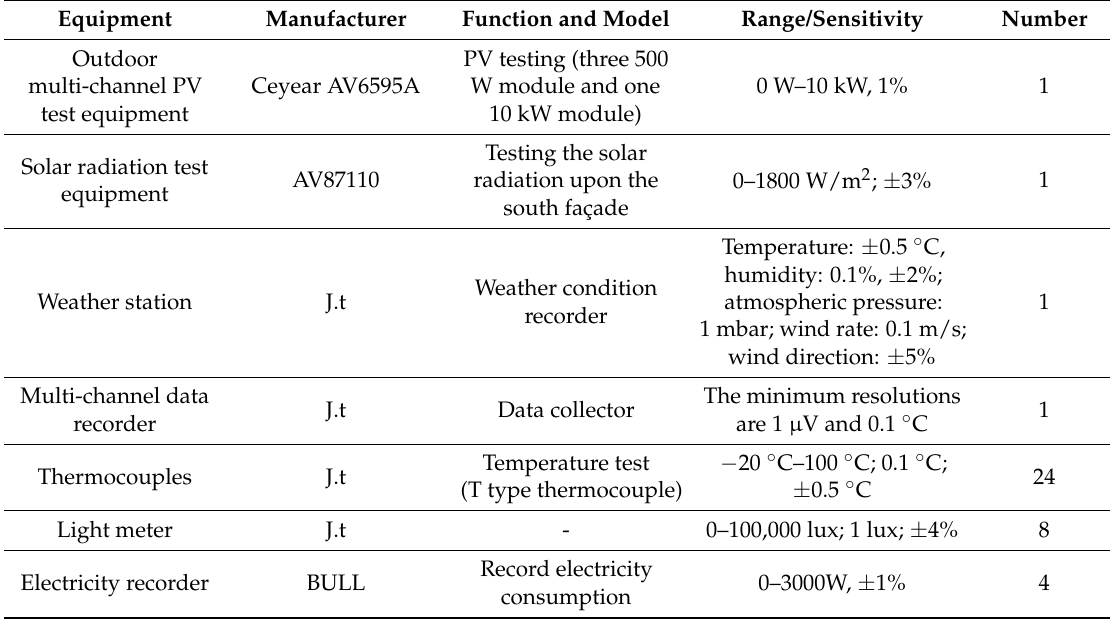
Table 2. The key instruments and their